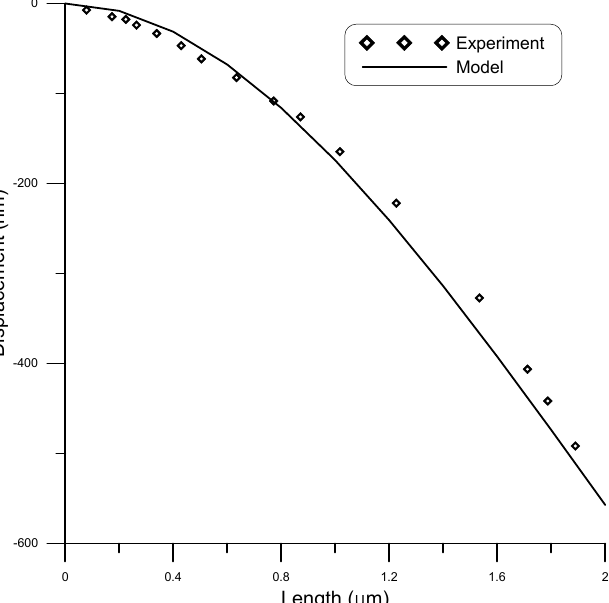
Figure 15. Displacement of a 2 µ m long beam of rectangular cross-section of 150 nm width and 50 nm thickness under a load of 2.1 nN, compared to experimental data